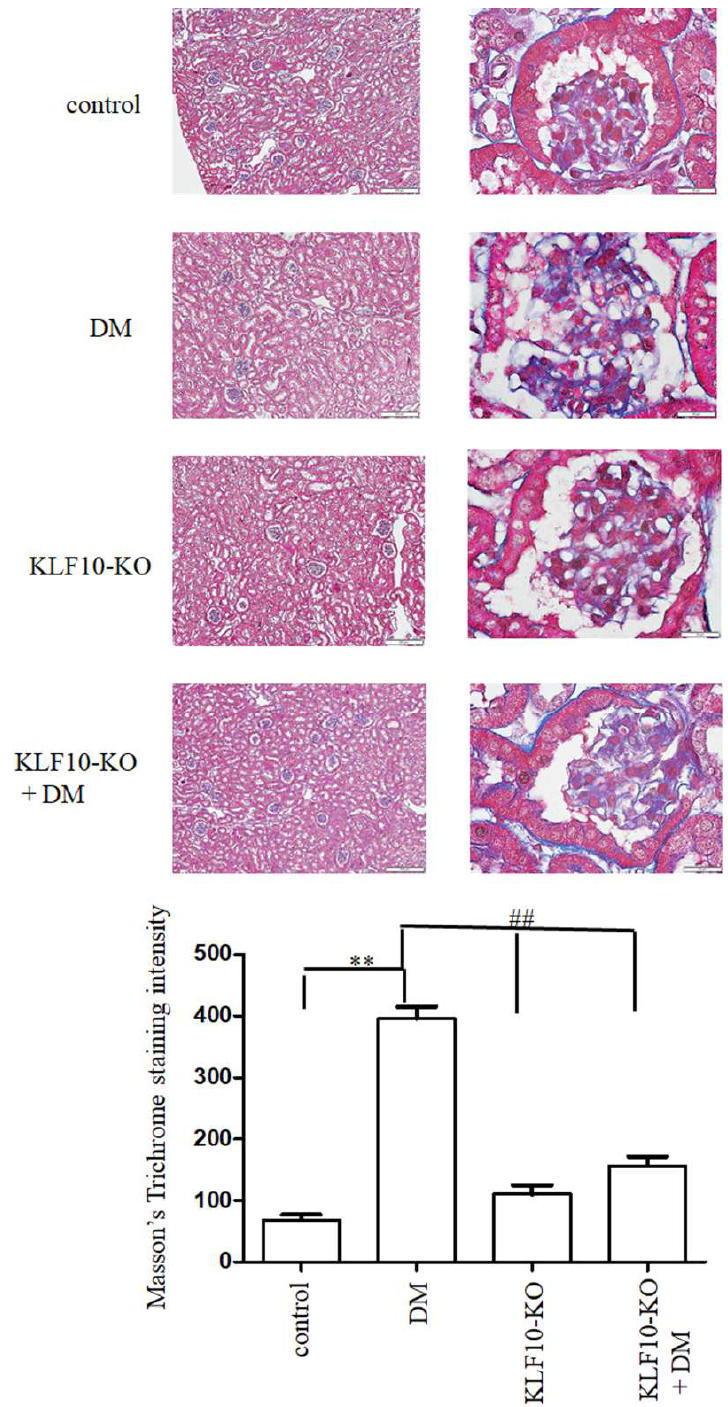
Figure 5. Knockout of KLF10 ameliorated diabetic renal fibrosis. Masson’s Trichrome staining was conducted to determine the renal fibrosis level (upper panels; left: magnification of 100 × , right: magnification of 1000 × ). Lower panel: data are presented as means ± standard deviation from three different mice **: p < 0.01 compared with the control group. ##: p < 0.01 compared with the DM group. Scale bar: 200 µ M at 100 × and 20 µ M at 1000 ×.